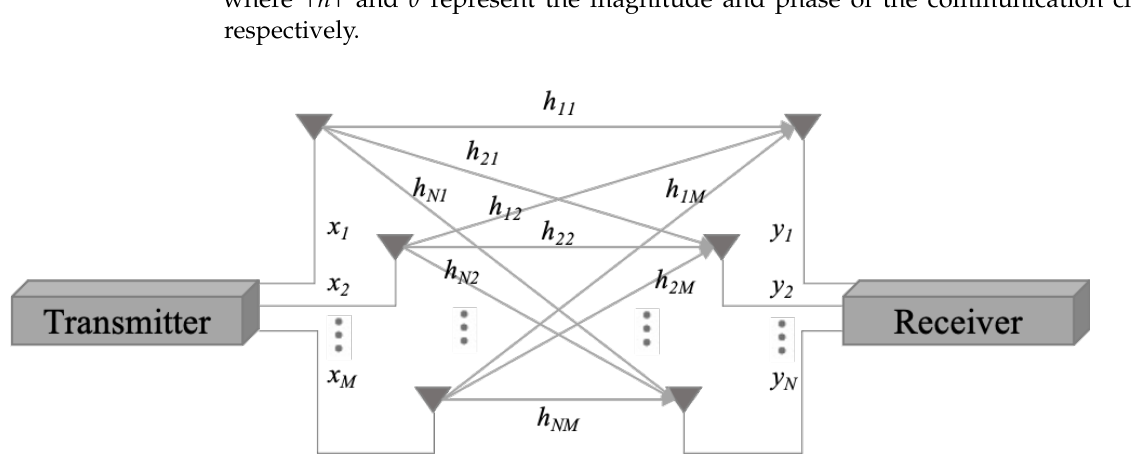
Figure 1. Multiple Input Multiple Output